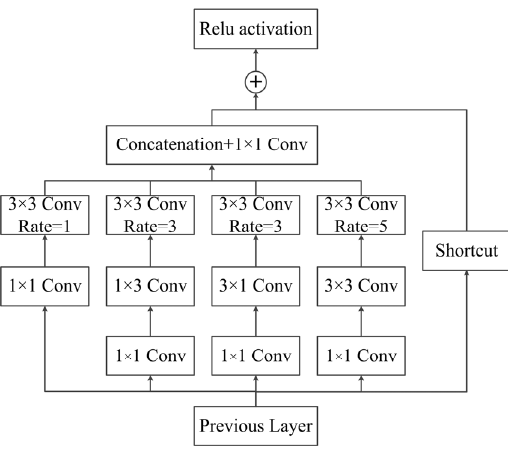
Figure 3. RFB structure diagram [13].